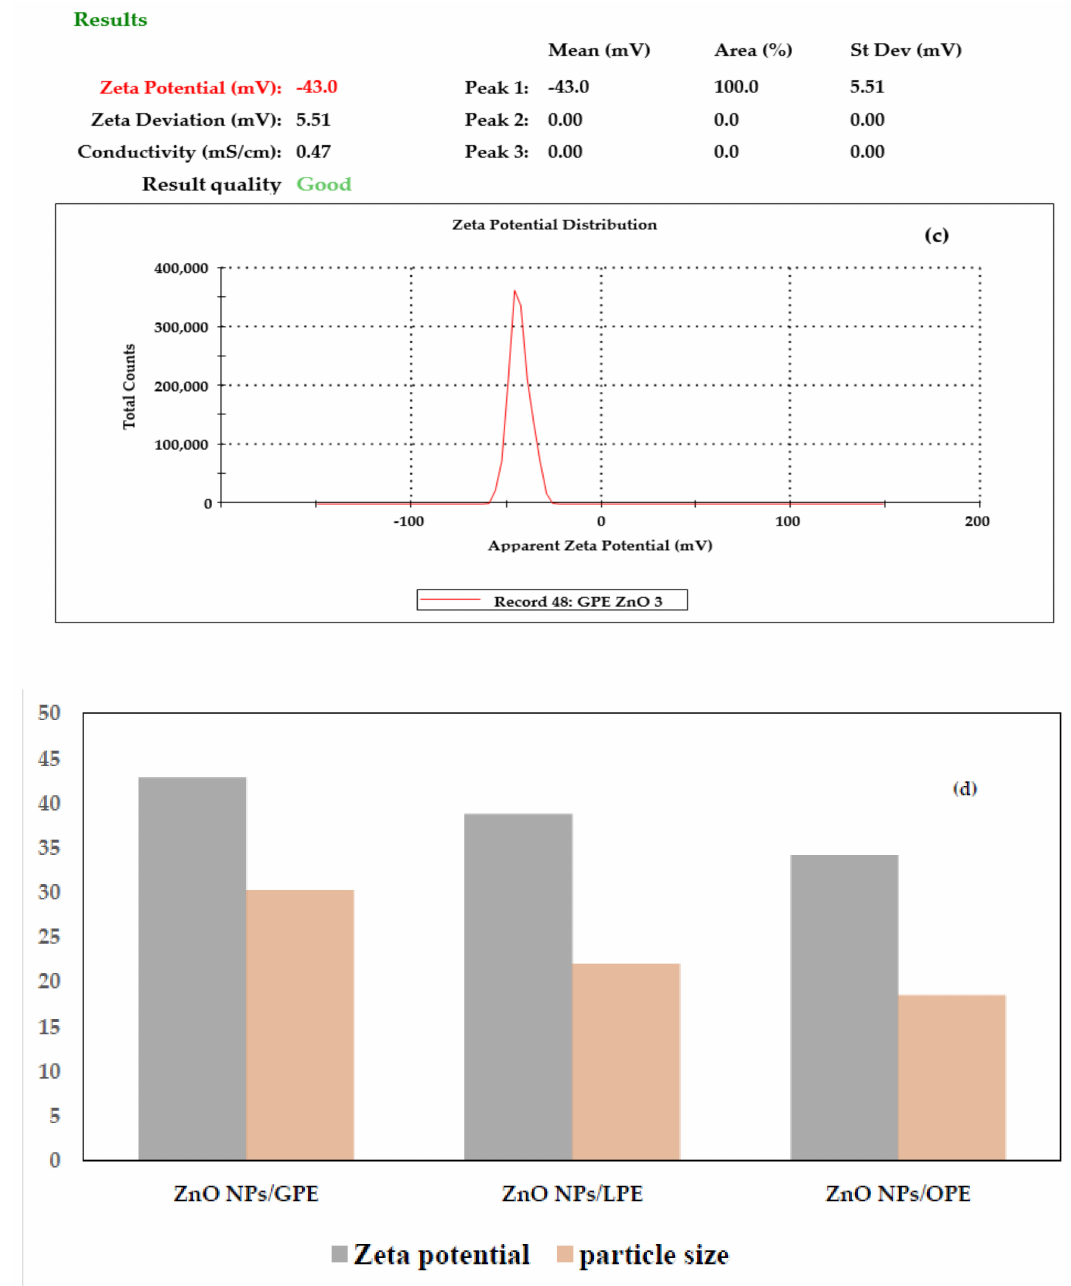
Figure 5. The ζ result of ZnO NPs from ( a ) OPE ( b ) LPE and ( c ) GPE ( d ) showed the comparative zeta potential and particle sizes of the ZnO NPs from the peel citrus